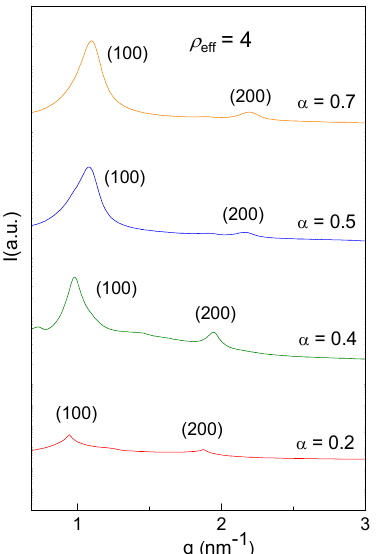
Figure 2. SAXS diffractograms of C 3 (C 16 His) 2 /DOPE-pDNA lipoplexes at an effective charge ratio ρ eff = 4 and several molar fractions of the C 3 (C 16 His) 2 cationic lipid in the C 3 (C 16 His) 2 /DOPE mixed lipid ( α ).